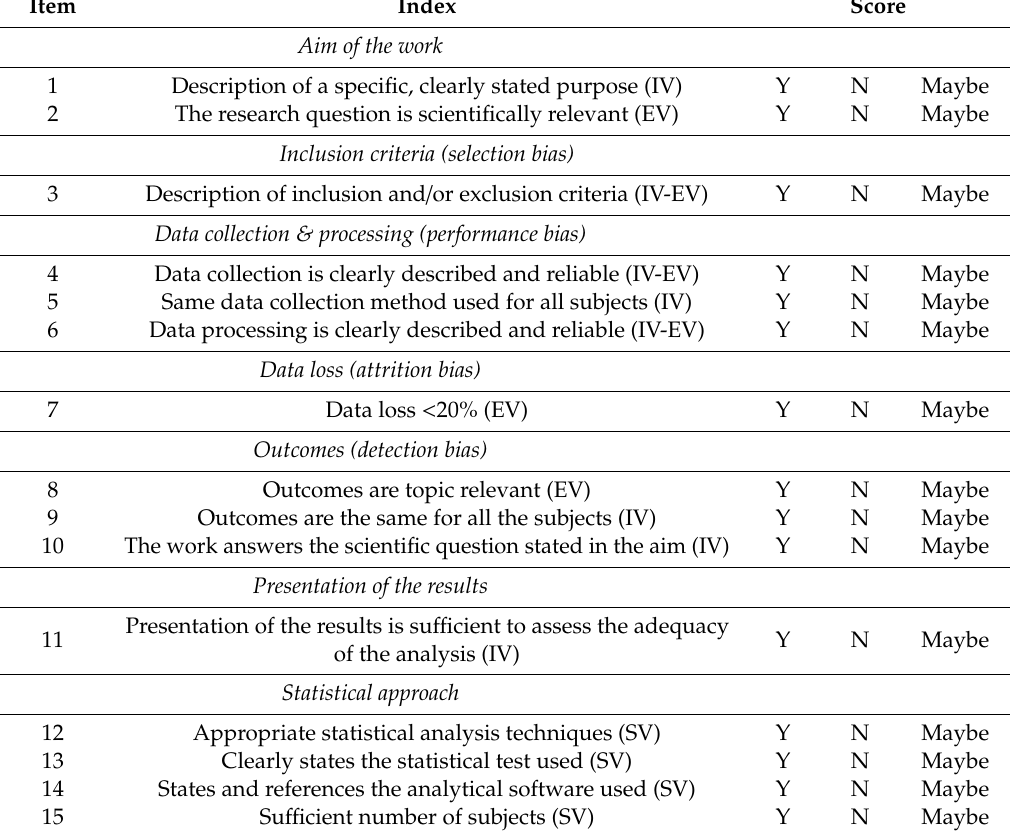
Table 1. Proposed checklist for the quality assessment of internal validity, statistical validity, and external validity: Reproduced and modified with permission from J. Taborri et al., Feasibility of Muscle Synergy Outcomes in Clinics, Robotics, and Sports: A Systematic Review; published by Hindawi,